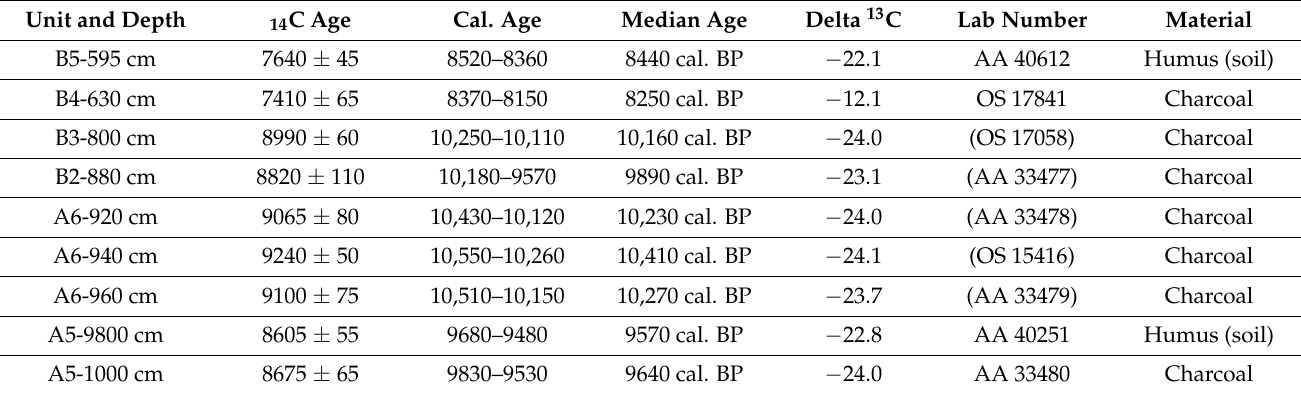
Table 1. Upper Arroyo. Main unit, lower part, radiocarbon, and AMS dates (rejected dates in parentheses). Reprinted/adapted with permission from Ref. [13], 2008, Karl Butzer. Unit and Depth